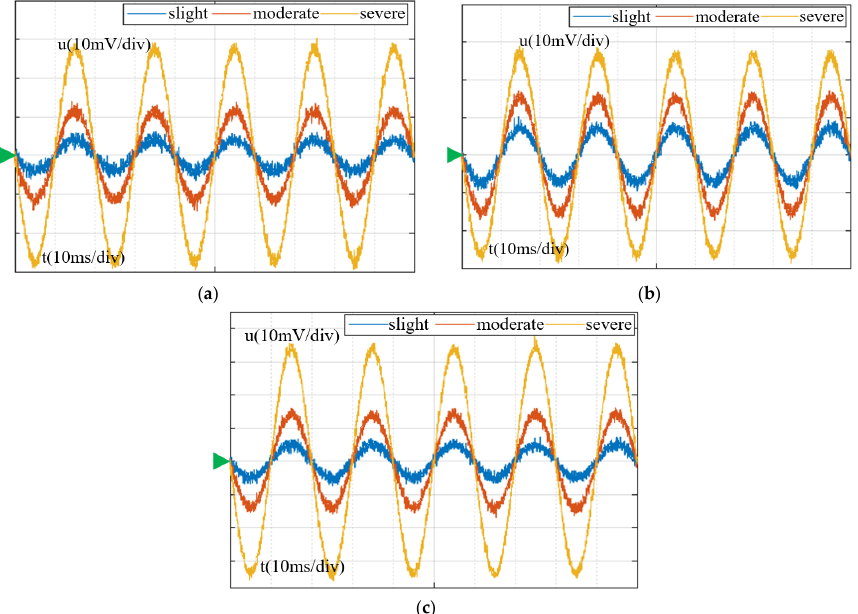
Figure 19. Voltage waveforms change in different moisture states of each sample. ( a ) sample 1; ( b ) sample 2; and ( c ) sample 3.